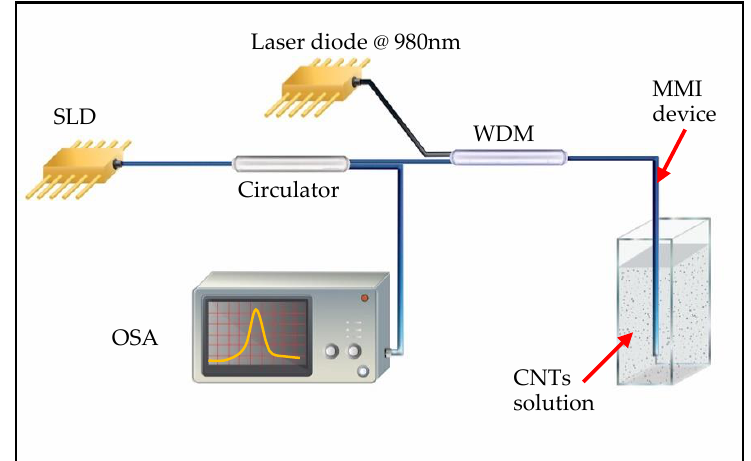
Figure 1. Schematic representation of the optical setup used in this study. SDL: superluminescent laser diode operating at 1550 nm with FWHM of 80 nm; WDM: wavelength division multiplexer; MMI device: multimode interference fiber device; CNTs solution: carbon nanotubes solution and OSA: optical spectrum analyzer. The depicted setup allows the fabrication of laser-induced deposition of CNTs and also the registration of the reflected spectrum of a broadband source.